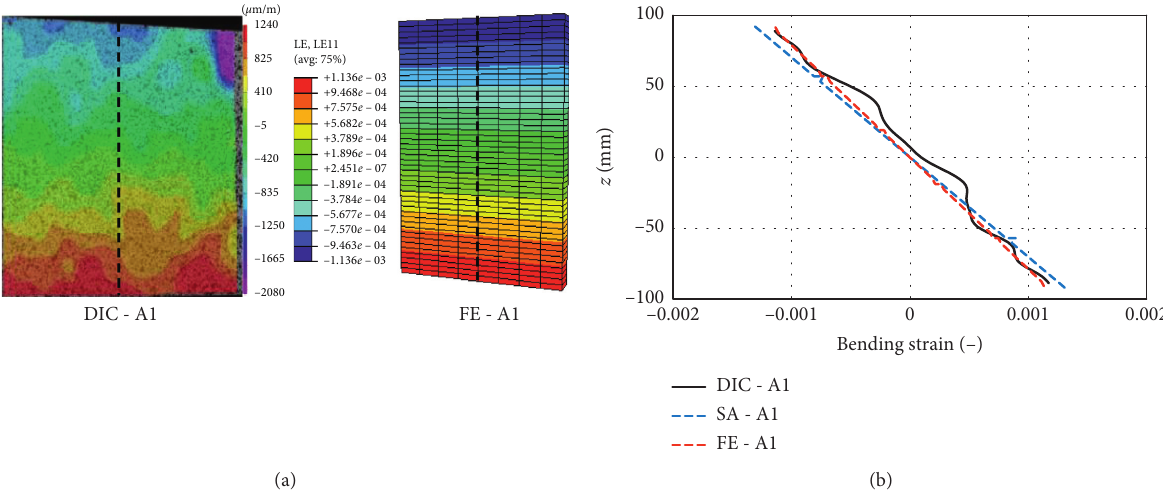
Figure 15: Colour contour plots and normal strain distribution from bending tests for A1.